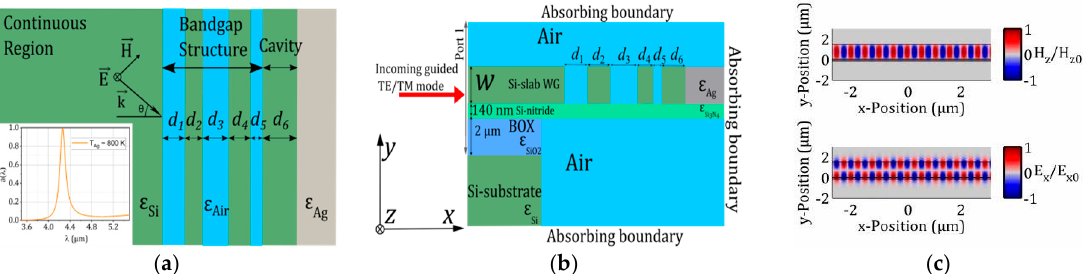
Figure 1. 1-D Simulation domain of the conventional TPP structure for the Transfer-Matrix Method ( a ) and 2-D FEM simulation domain of the slab TPP structure ( b ). The inset in ( a ) shows the absorption performance of the GA optimized stack configuration. The even (cid:1834) (cid:1878) profile (upper panel) and the odd (cid:1831) (cid:1876) profile of the pure TM slab mode is shown in ( c ).